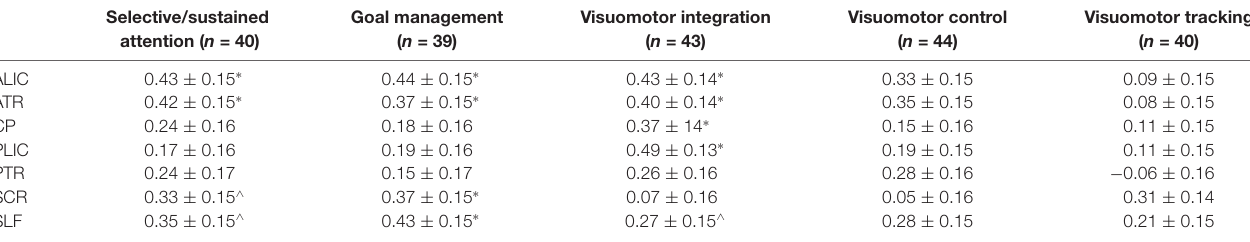
TABLE 3 | Associations between individual cognitive and visuomotor control tasks and white matter tract integrity.